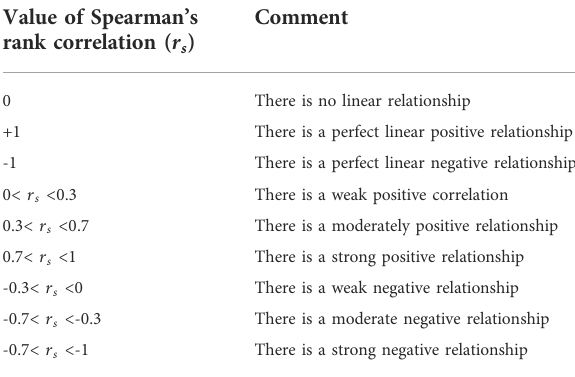
TABLE 12 Interpretation of Spearman ’ s rank correlation ( r s )